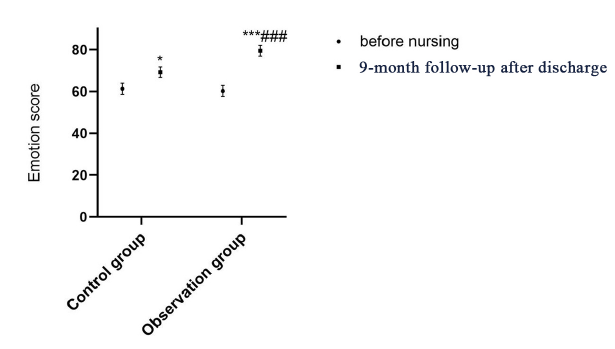
Fig. 4 - Comparison of emotional scores between the two groups before and after continuing care. Compared with on admission within the same group, *P<0.05, ***P<0.001; compared with the control group after continuing care, ### P<0.001.